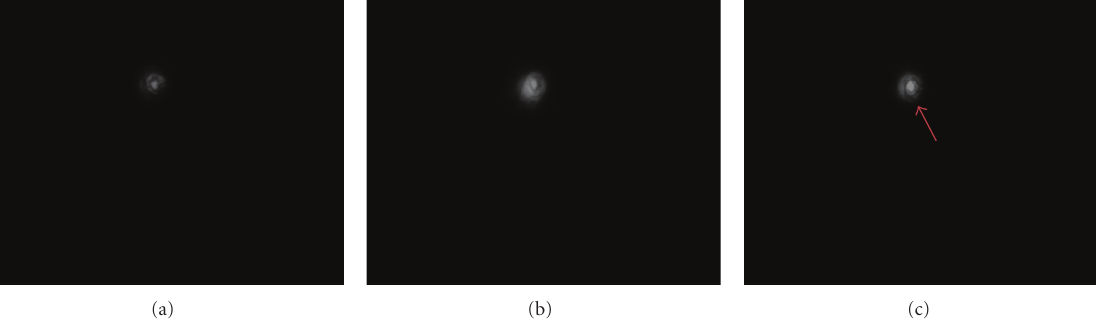
Figure 2: Images of cervical epithelial cells in liquid-based thin layer samples analyzed by CLASS microscopy. The photos show from left to right a normal, LSIL, and HSIL cell. Arrow: the nucleus. The diameter of the nuclei is larger than 2 µ m.